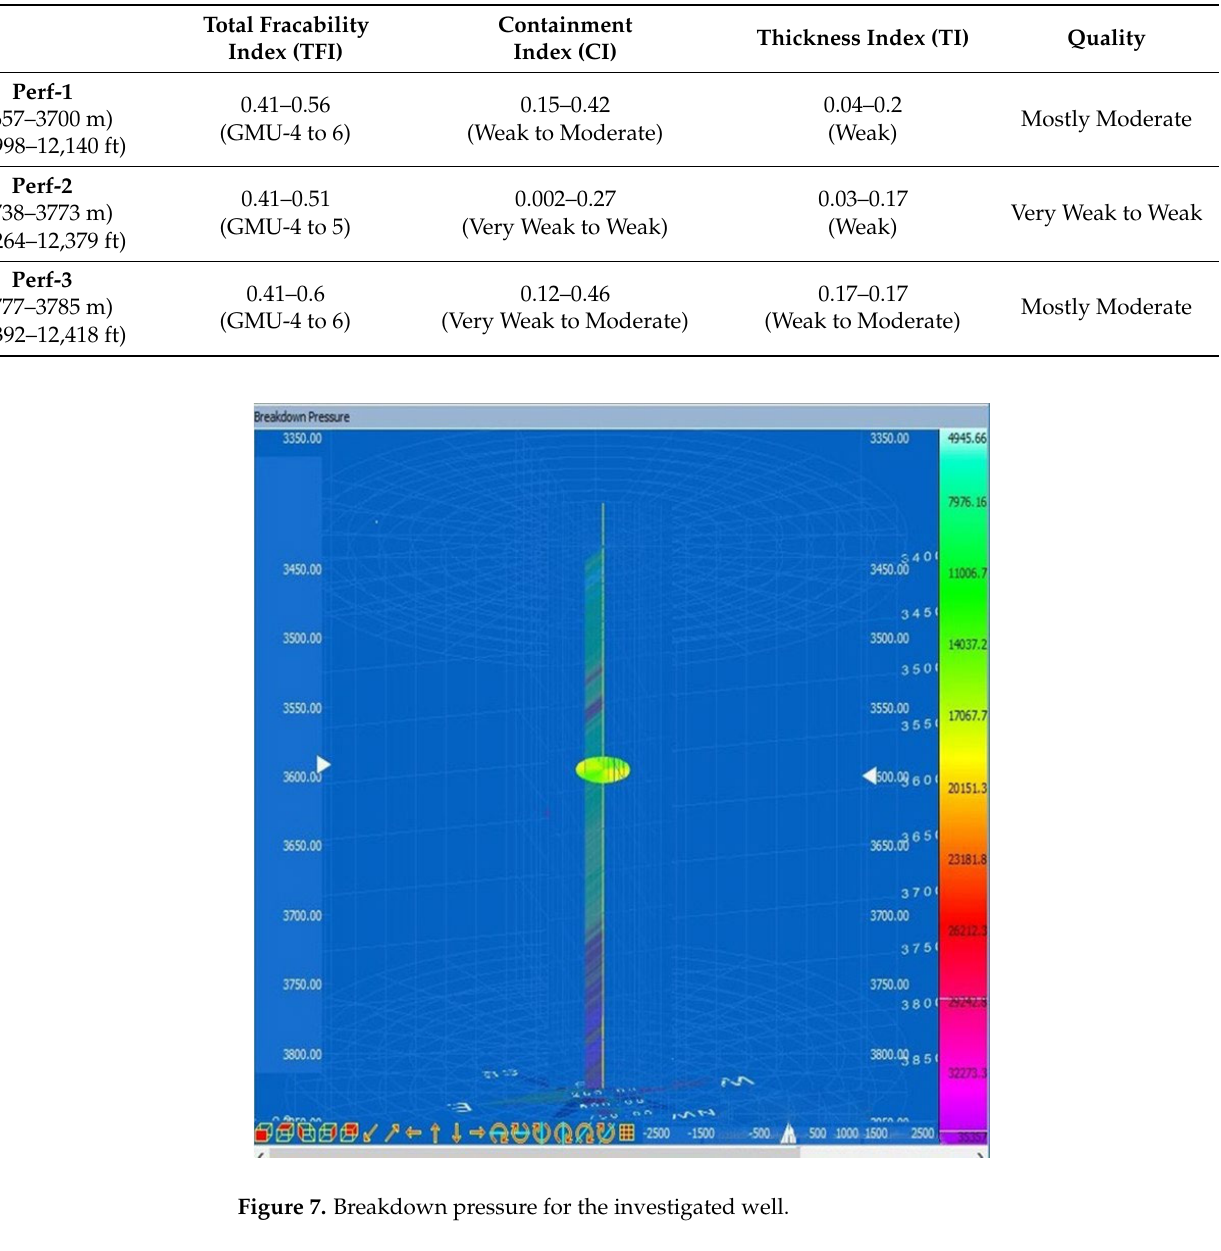
Table 2. Candidate selection indices or criteria for acid fracturing.